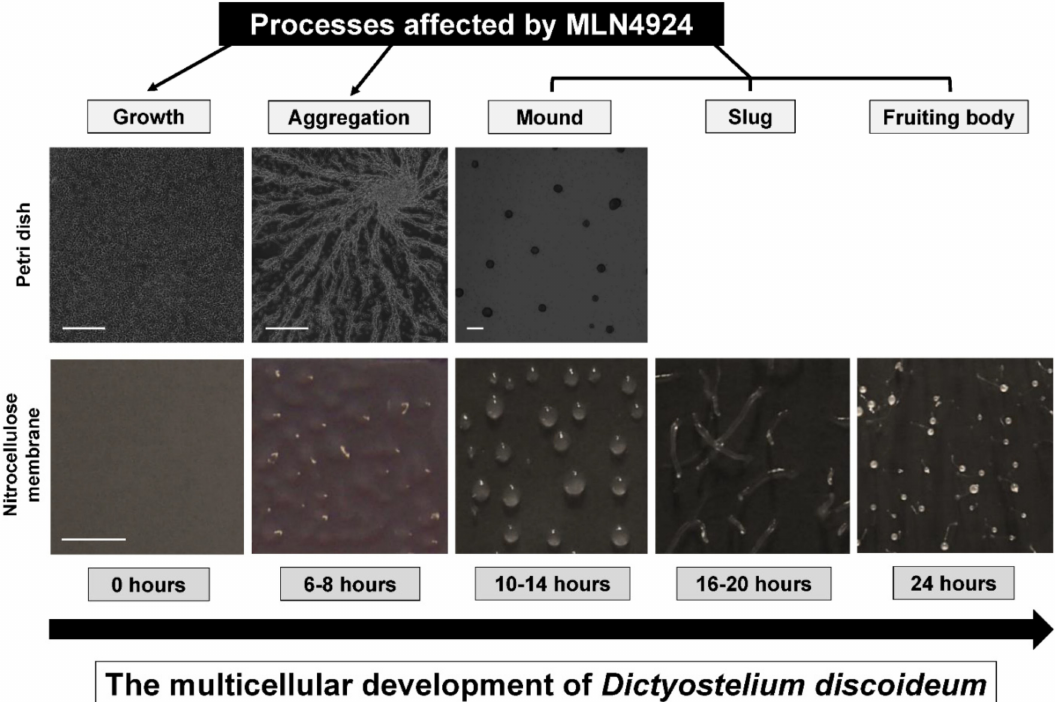
Figure 8. Processes affected by MLN4924 during the D. discoideum life cycle. MLN4924 inhibits cell proliferation, chemo- taxis, aggregation, and fruiting body formation, indicating that neddylation/de-neddylation regulates these cellular and developmental events during the D. discoideum life cycle. Images show the development of D. discoideum cells in two experimental environments commonly used in the laboratory: (1) cells adhered to Petri dishes and submerged in KK2 buffer and (2) cells deposited onto nitrocellulose membranes soaked in KK2 buffer. Note: Cells submerged in KK2 buffer do not develop past the mound stage. Scale bars (Petri dish) = 250 µ m. Scale bar (nitrocellulose membrane) = 1000 µ